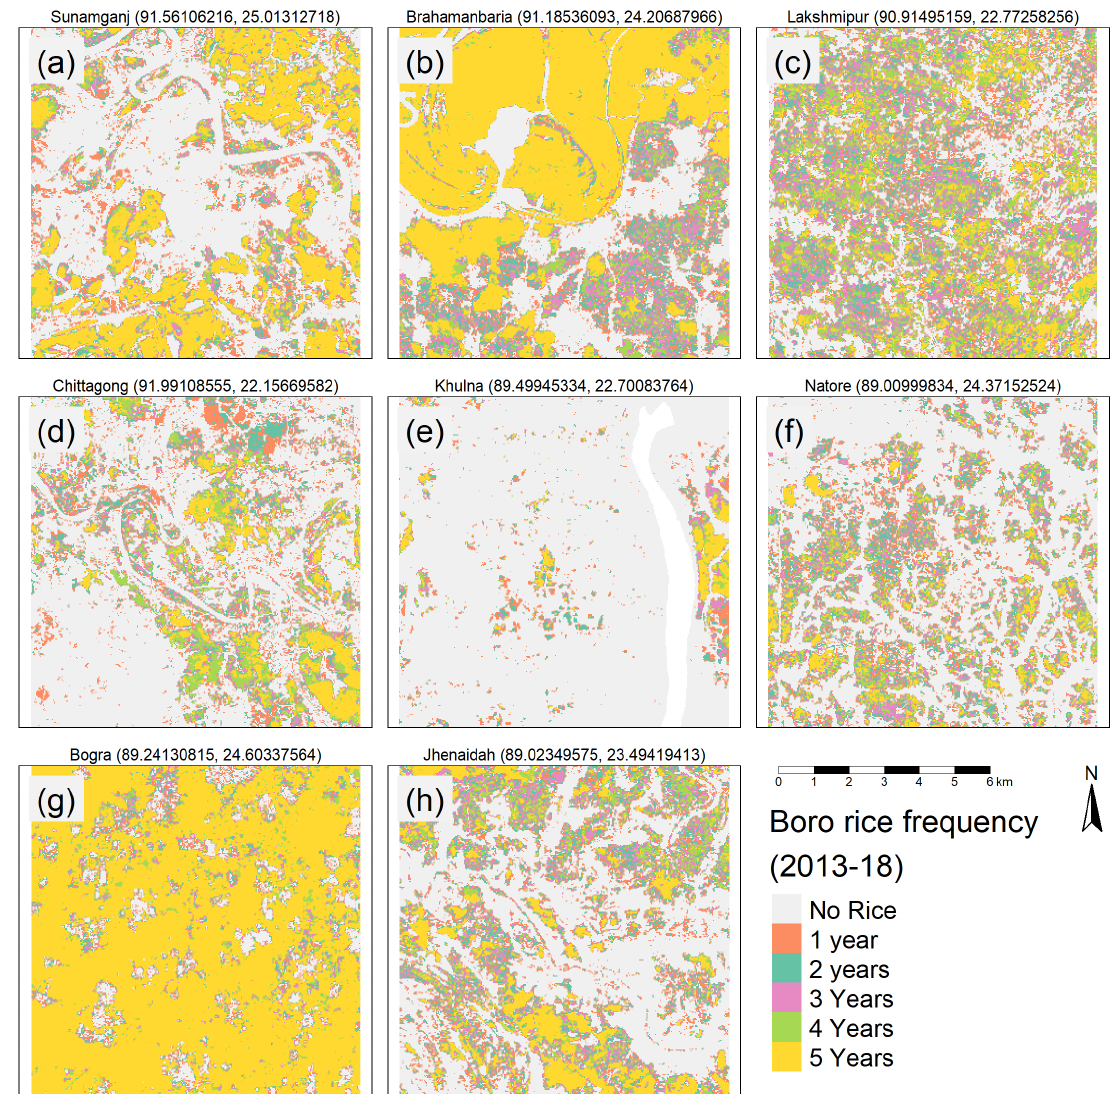
Figure 6. Regional differences in rice-planting frequency. ( a – h ). Boro rice frequency plots at the center coordinates alongside the upazila name listed above each 10 km 2 map. In the legend, no rice includes all other land use land cover including crops where rice was never grown during 2013 and 2018; 1 year to 5 years represent pixels classified as boro rice for the period of time between 2013 and 2018.